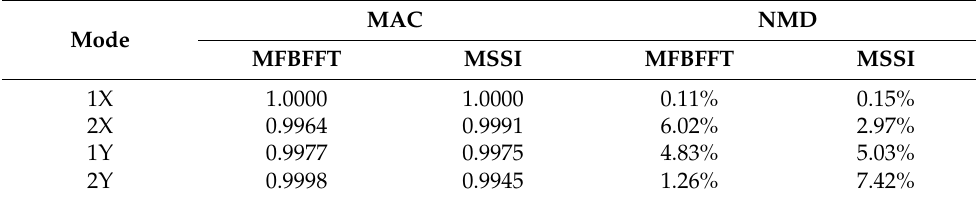
Figure 5. Comparison of the mode shapes for a numerical model of the structure. Table 3. Correlation index of the identified and FEM mode shapes.